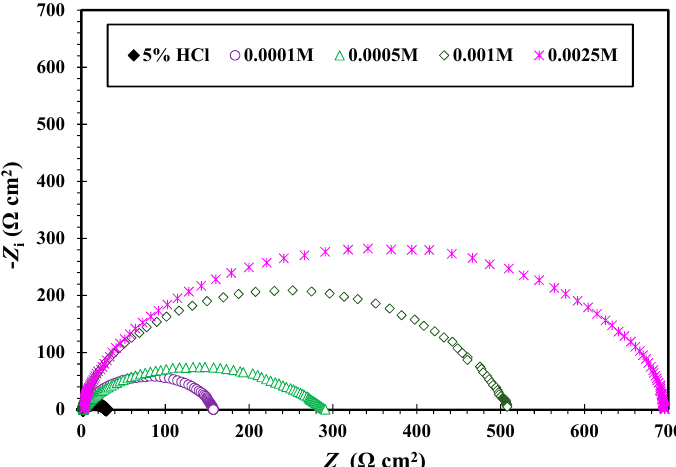
Figure 8. Nyquist plots for MS in 1 M HCl in the absence and presence of different concentrations of CGSES14 at 20 °C.